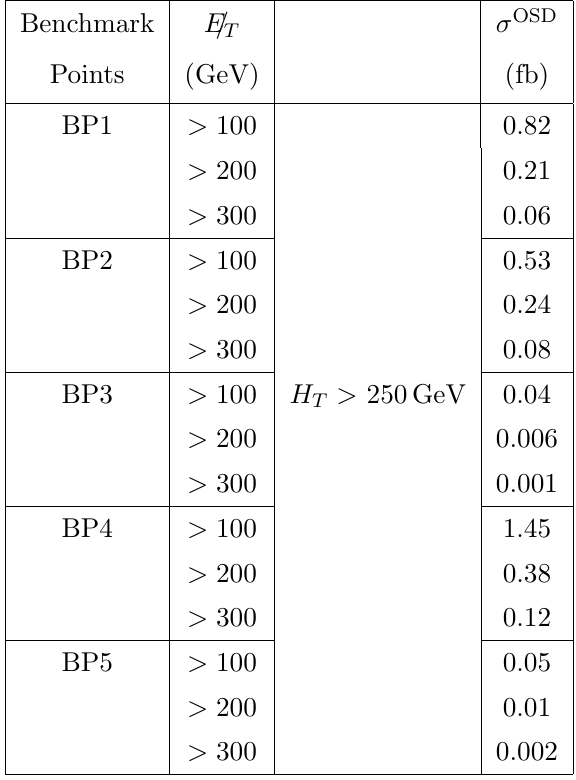
Table 4 . Variation of (cid:12)nal state signal cross-section with MET cut for a (cid:12)xed cut on H T > 250 GeV. p All simulations are done at s = 14